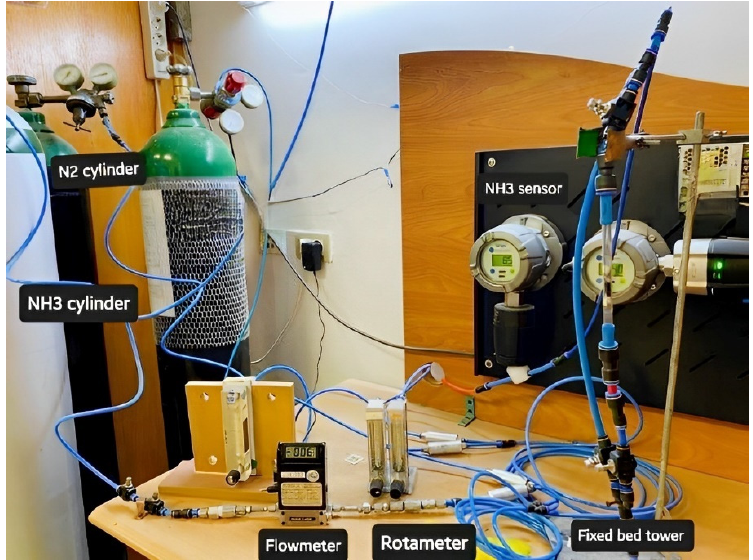
Figure 1. Experimental setup of ammonia preparation and adsorption